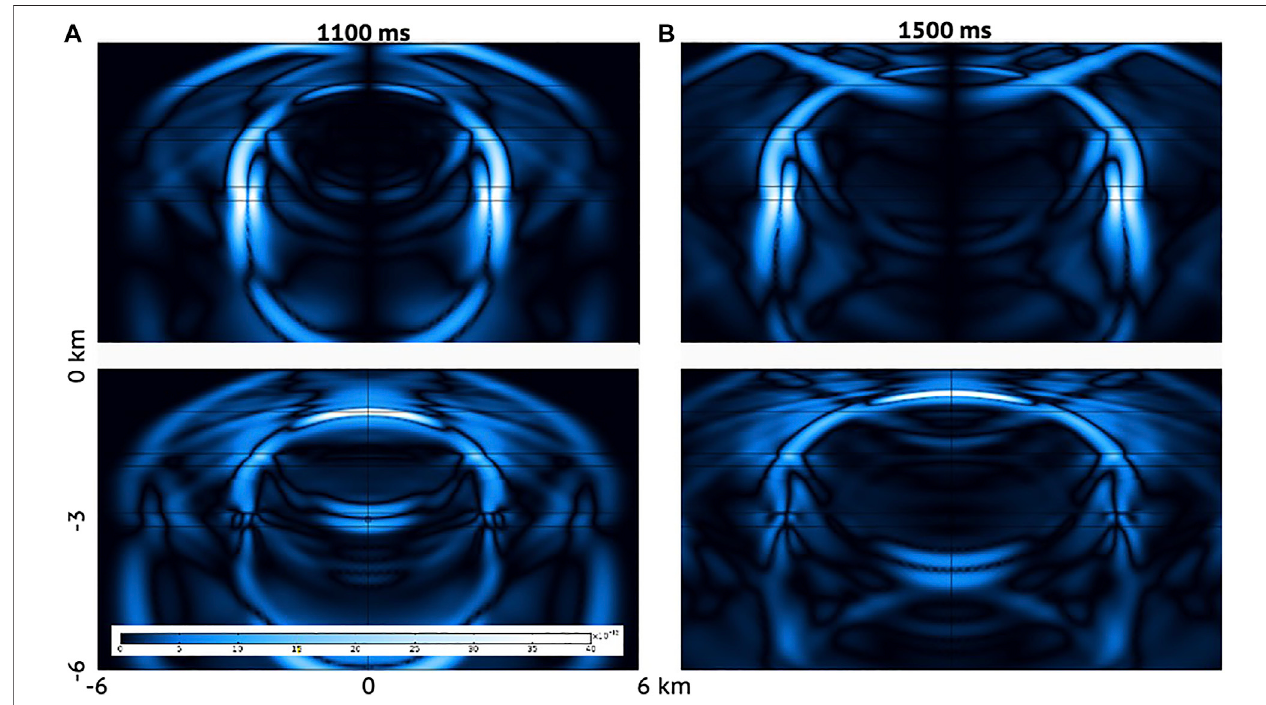
FIGURE 5 | 2D full wave form fi nite difference model snapshots of absolute vertical (top) and horizontal (bottom) particle velocity for (A) 1100 ms after start of the earthquake, (B) 1500 ms. All panels have the same distance and particle velocity scale as the panel in the bottom left. The used velocity model is shown in Supplementary Figure S1